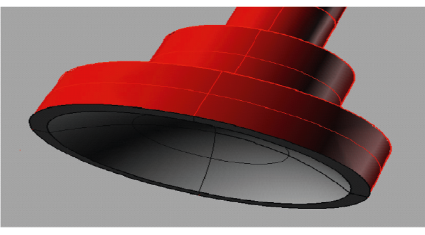
Figure 4: Plug with concave shape no 2.